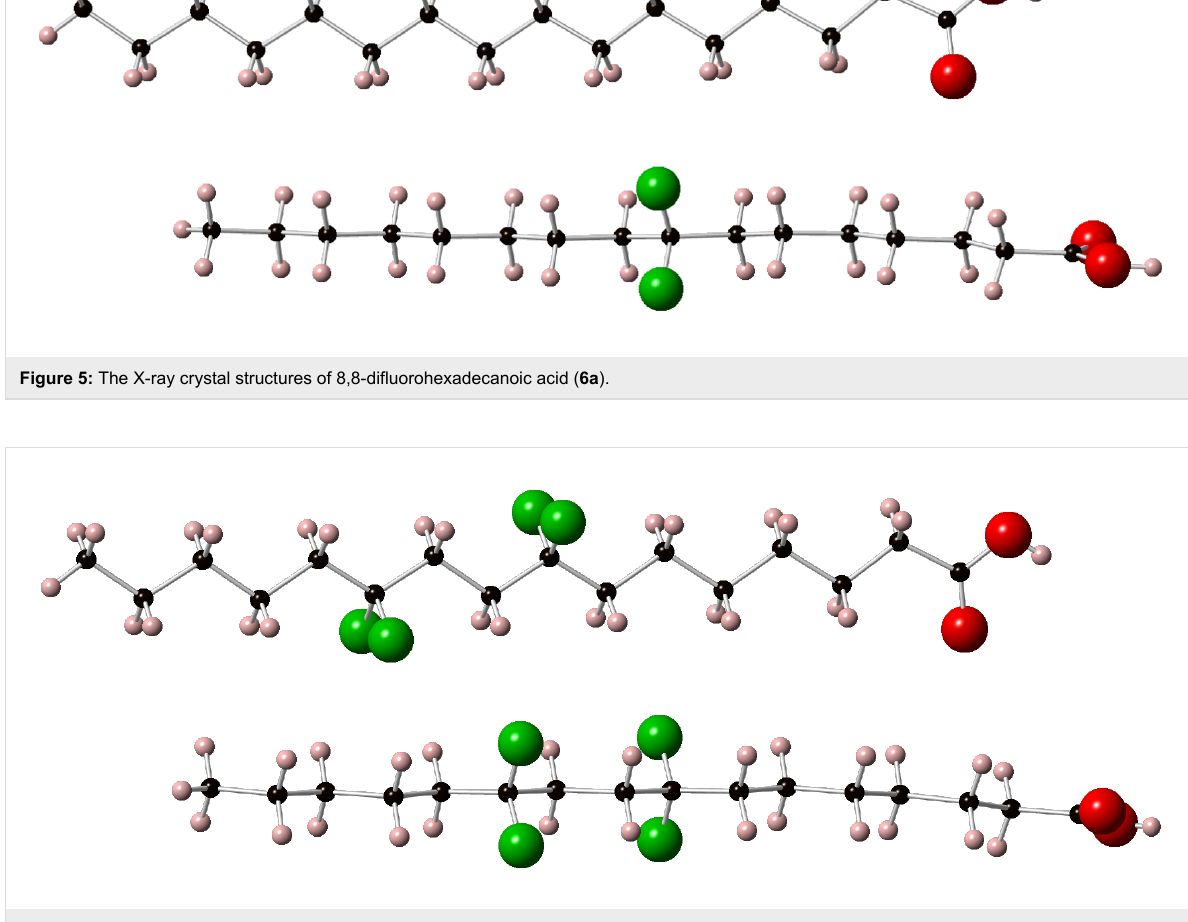
Figure 6: The X-ray structure of 8,8,11,11-tetrafluorohexadecanoic acid ( 6c ).